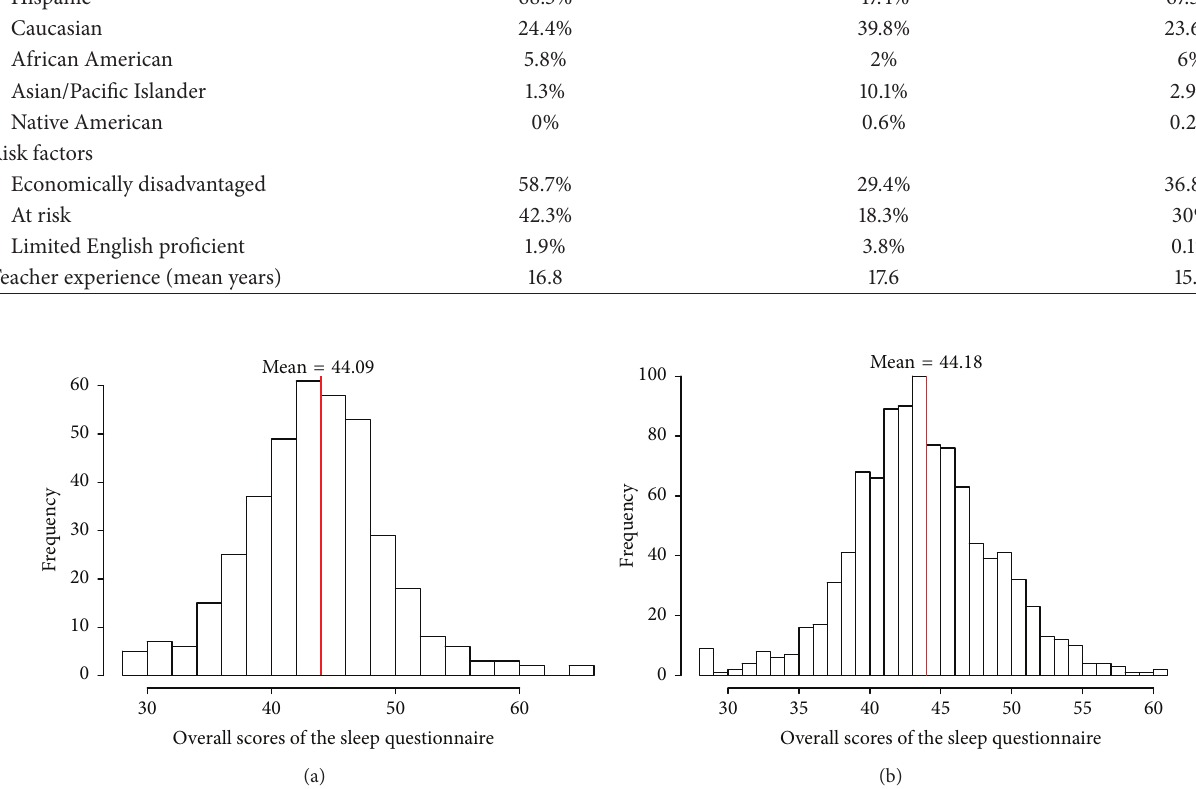
Figure 1: Distribution of the total questionnaire scores for elementary (a) and middle (b) school